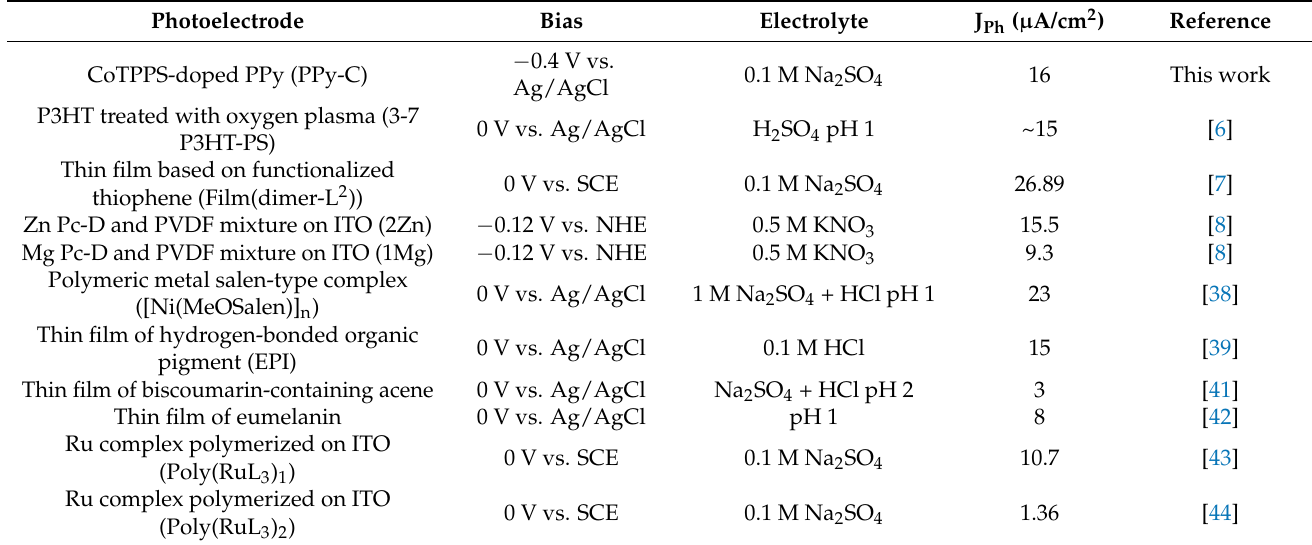
Table 2. Comparison of photocurrent densities (J Ph ) in photoelectrochemical oxygen reduction. Pc-D refers to phthalocya- nine derivative. Photoelectrode Bias Electrolyte J Ph ( µ A/cm 2 )